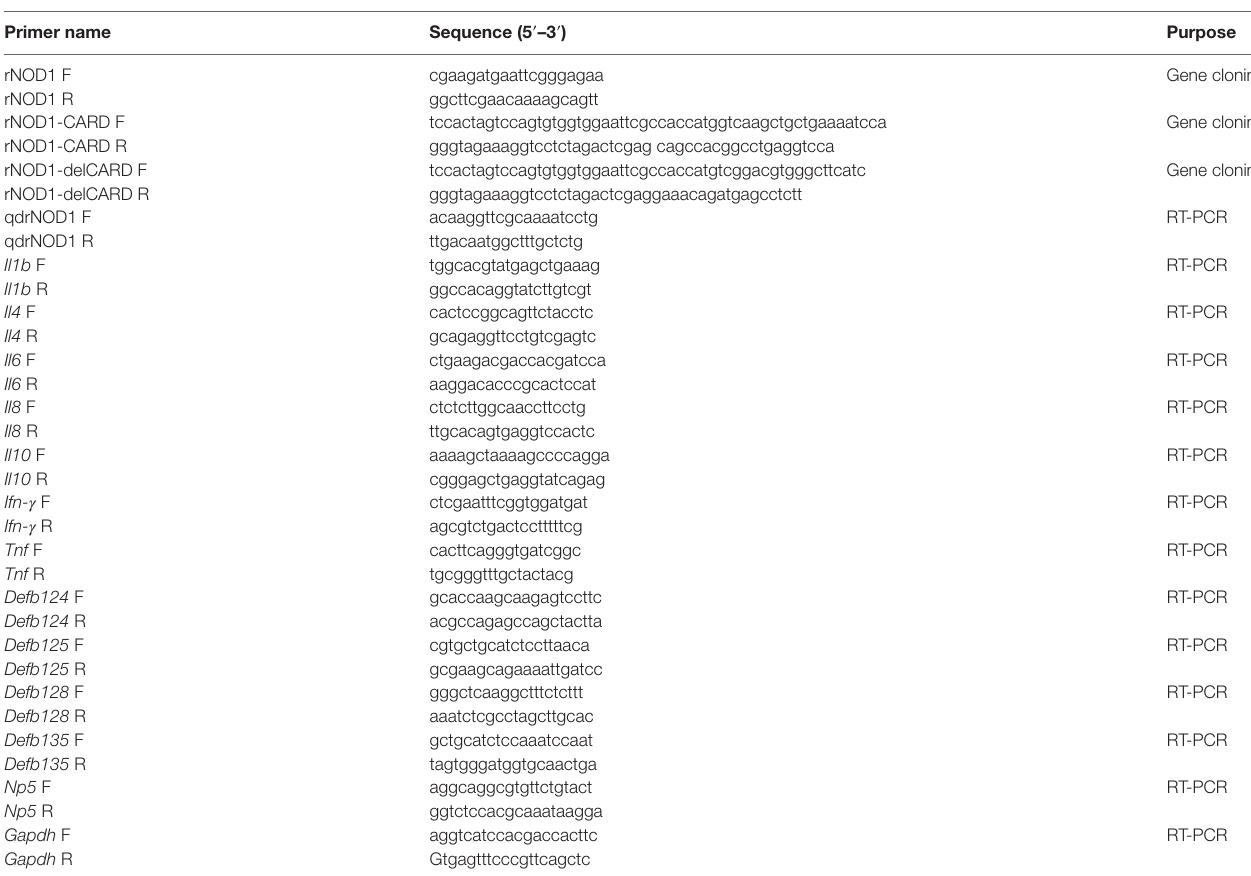
TaBle 1 | Primers used in this